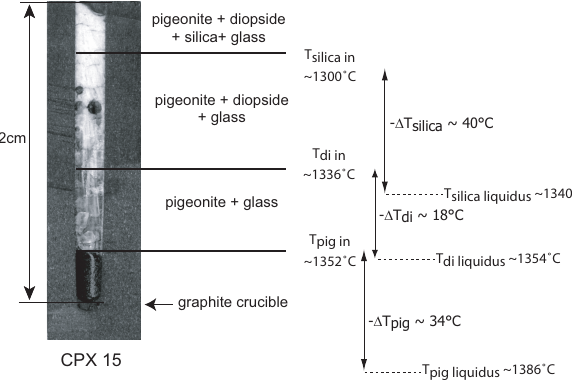
Figure 1. Details of the four cooling procedures used during dy- Fig. 1. Details of the four procedures of cooling used during dynamic crystallization experiments. namic crystallization experiments.